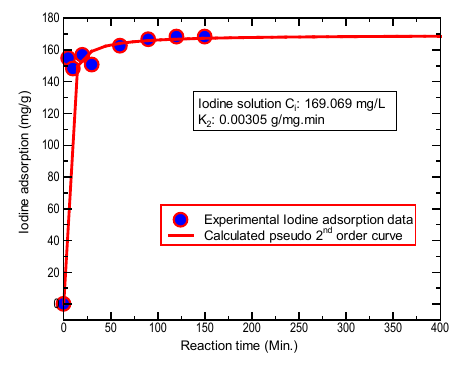
Fig. 8. Kinetic plots for the adsorption of Iodine on ASL-2 Mechanism of iodine adsorption: The